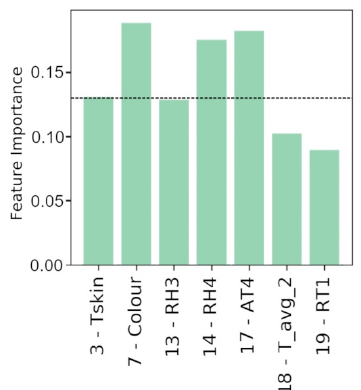
Figure 9. Relative feature importance of Extra Trees classifier using a restricted number of data to define PTCP_R. Table 7. Recursive Feature Elimination for R